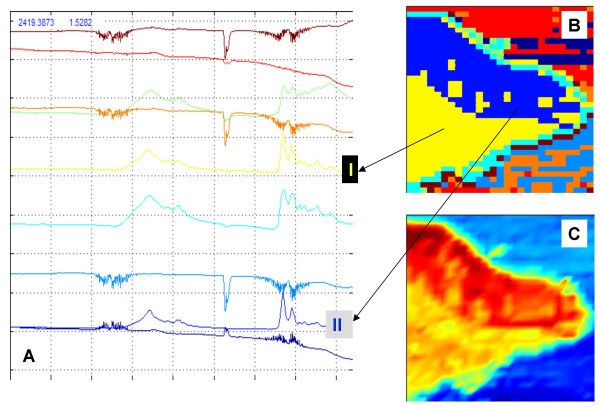
Cluster mapping of periodontal tissue. Average spectra were generated from nine groups based on their overall spectral features (A); each representing one class in the cluster map of periodontal tissue (B) produced by the cluster analysis. Good correlation can be observed between the cluster mapping (B) and corresponding chemical mapping (protein) (C) based on the differential spectral features of the epithelial and connective tissues.